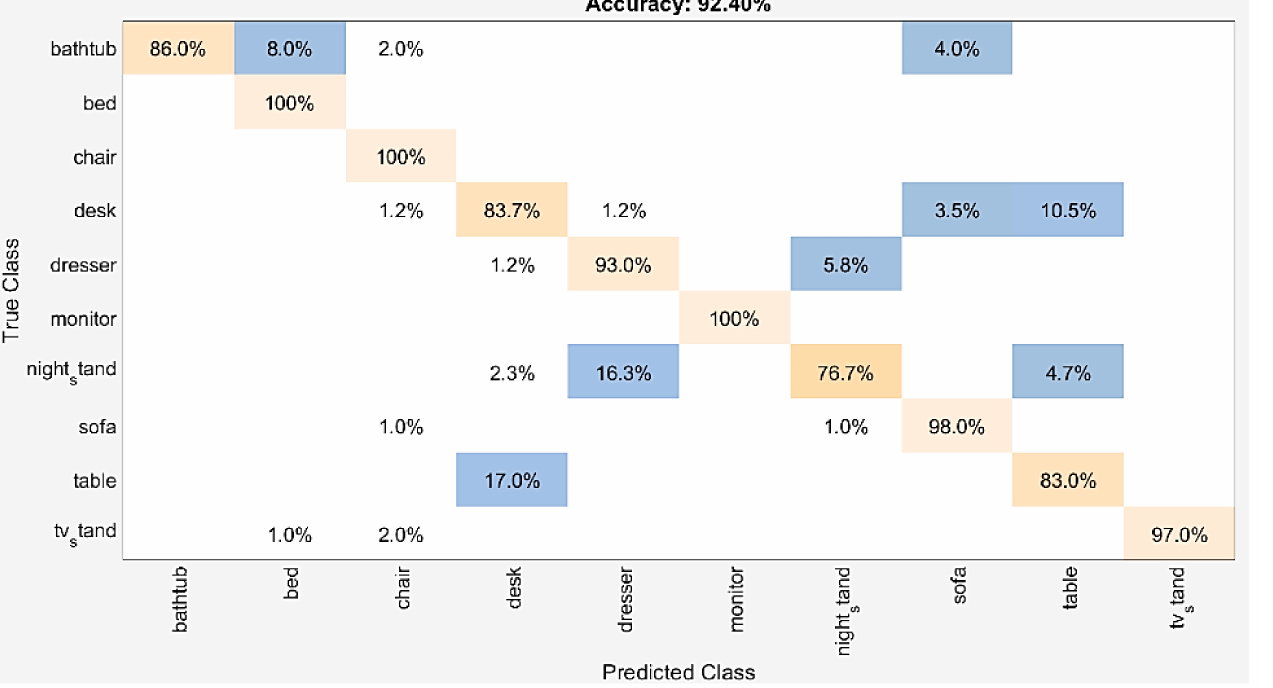
Figure 6. The confusion matrix for dataset: